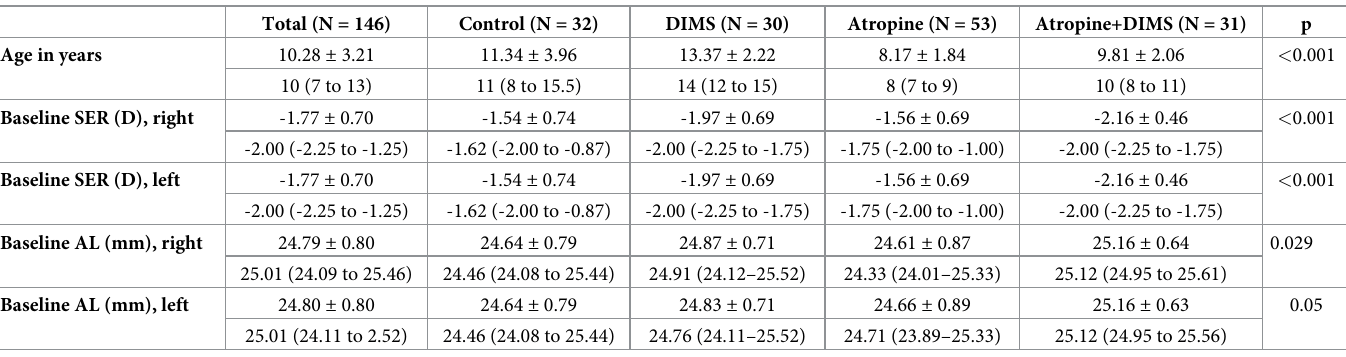
Table 2. Participant characteristics at baseline 1 .